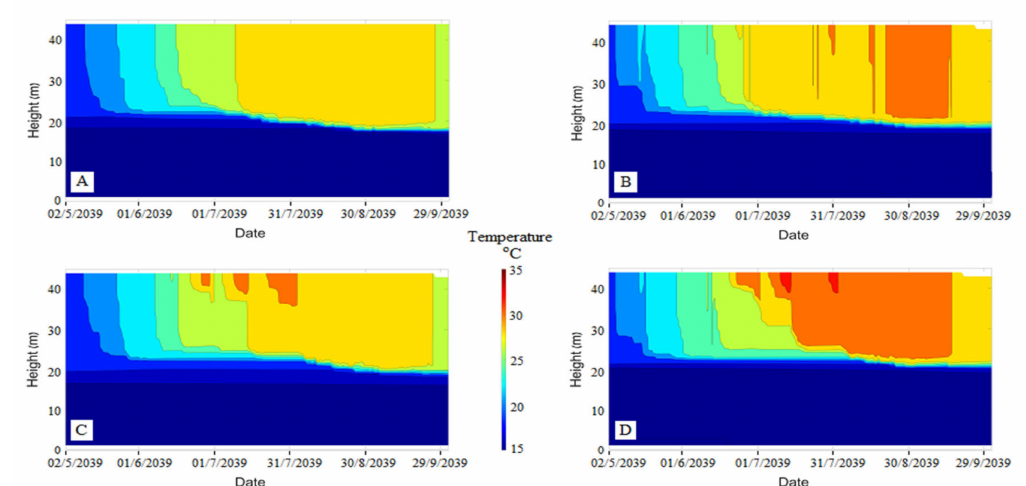
Figure 10. Representative GLM results of the four scenarios, Unchanged ( A ), LI ( B ), HW ( C ) and HW-LI ( D ), for the summer of the final year of the simulation (May–September 2039).